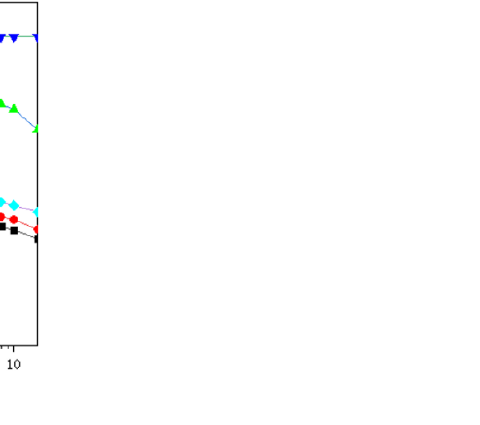
Figure 6. Comparison between the mean free path (MFP) for the TPB glasses with different radiation shielding glass.